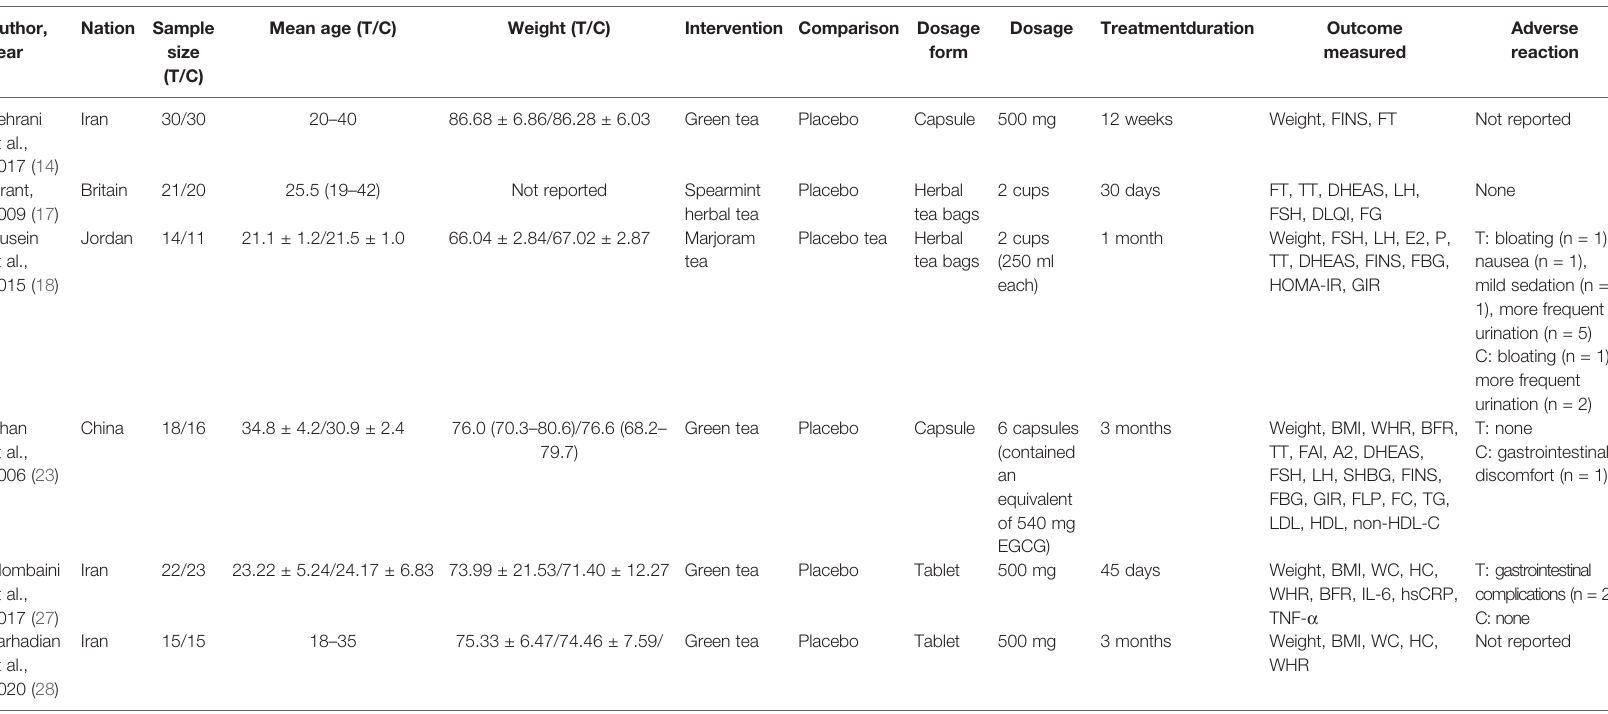
TABLE 2 | The characteristics of the included